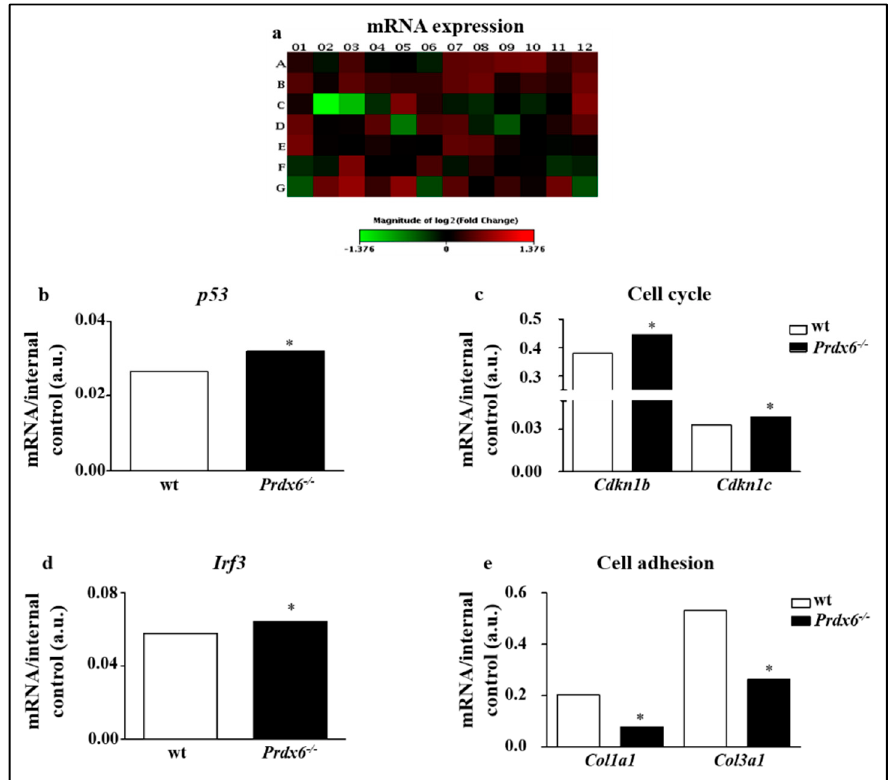
Figure 1. Prdx6 -/- mice showed altered senescence genes profile. ( a ) Heatmap of expression changes in 84 key genes involved in the initiation and progression of cellular senescence in gastrocnemius skeletal muscle of Prdx6 -/- mice. ( b–e ) Detailed expression levels of the indicated genes and pathways modulated in Prdx6 -/- compared to control group. Bar graphs report the average mRNA levels reported as mean ± SD with the respective p-values automatically calculated by the QIAGEN program. All values were normalized with internal controls. * p < 0.05 ( n = 5 mice per group).